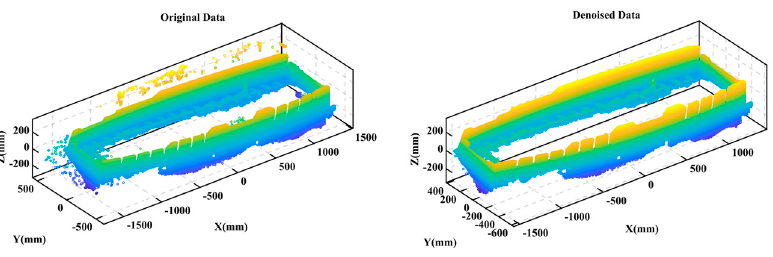
Figure 10. The point cloud denoising result of the wing box.